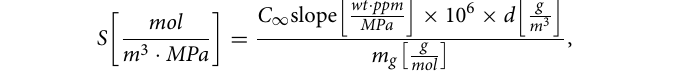
Figure 6. ( a ) Gas uptake ( C shaped NBR with different thicknesses. R and T indicate the radius and thickness, respectively, of cylindrical